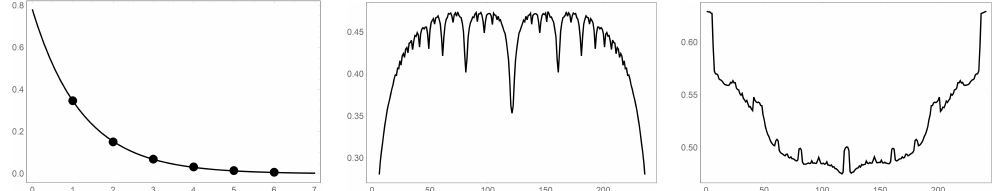
( 3 ) ( z ) versus j is shown on the left. The radii Figure 5. Radius of the Julia set for f 4 ( z ) of the sequence j h 4 are plotted along the ordinate and the abscissa is x, where j = 10 x . The data are fit to an exponential decay Ae − κ x (fit values: A = 0.779, κ = − 0.811). These data expose the very slow ( ≈ log ( log ( j )) penetration of the cleft structures in the base filled-in Julia sets ( θ = 0, c = 0). Plots of radius, in the middle and the area as a percentage of the unit disk, on the right, of the Julia sets, as θ ranges from 0 ◦ to 120 ◦ . The sharp downward peaks of the middle graph correspond to θ values where the spirals uncurl to stretch toward the origin. The area graph on the left shows that, although the graphs are not mirrored about the midpoint, the area of these graphs are similar.